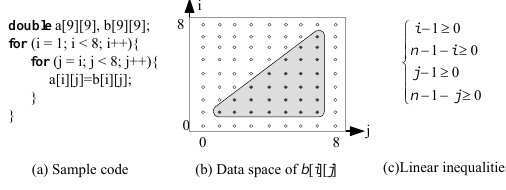
Figure 2. Linear inequalities system